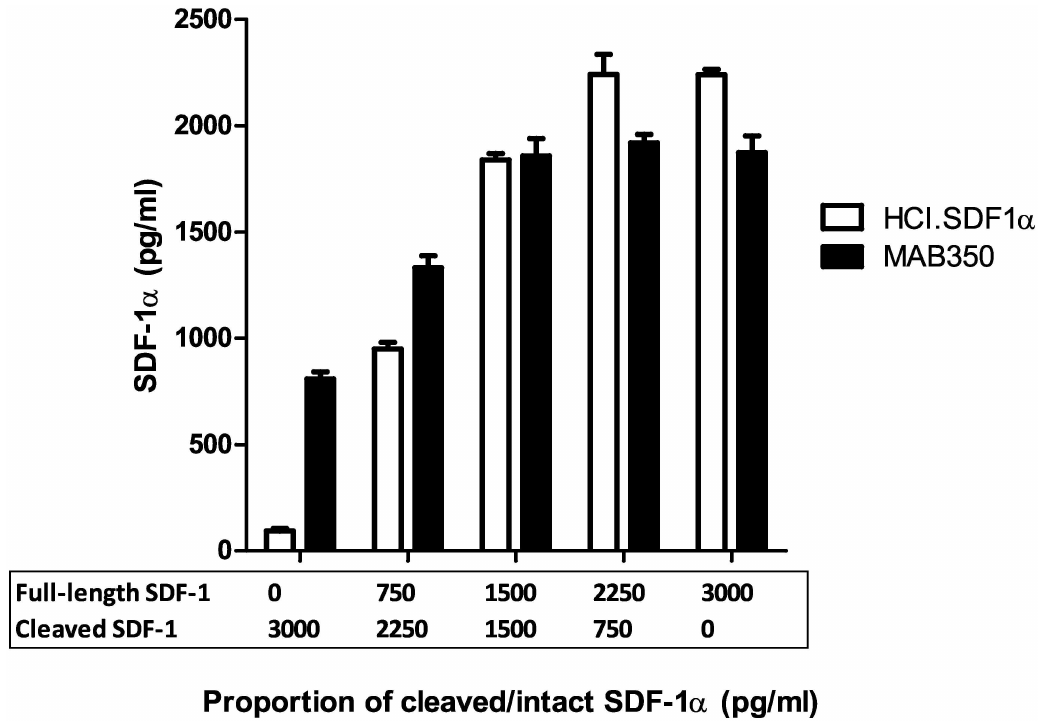
Fig 6. ELISA for intact and cleaved SDF-1 α using HCI.SDF1 and MAB350. An ELISA assay demonstrates that HCI. SDF1 is specific for active SDF-1 α ,with very low signal in the absence of intact SDF-1 α ,whereasthere is substantial residual signal in the absenceof intact SDF-1 α when using the commercialantibody MAB350.